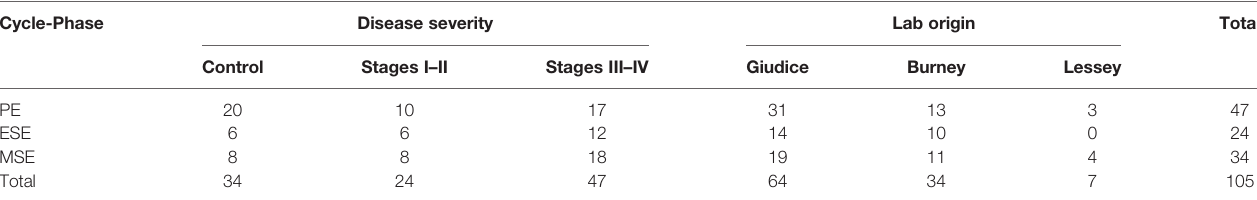
TABLE 1 | Cohort Statistics. Cycle-Phase Disease severity Lab origin